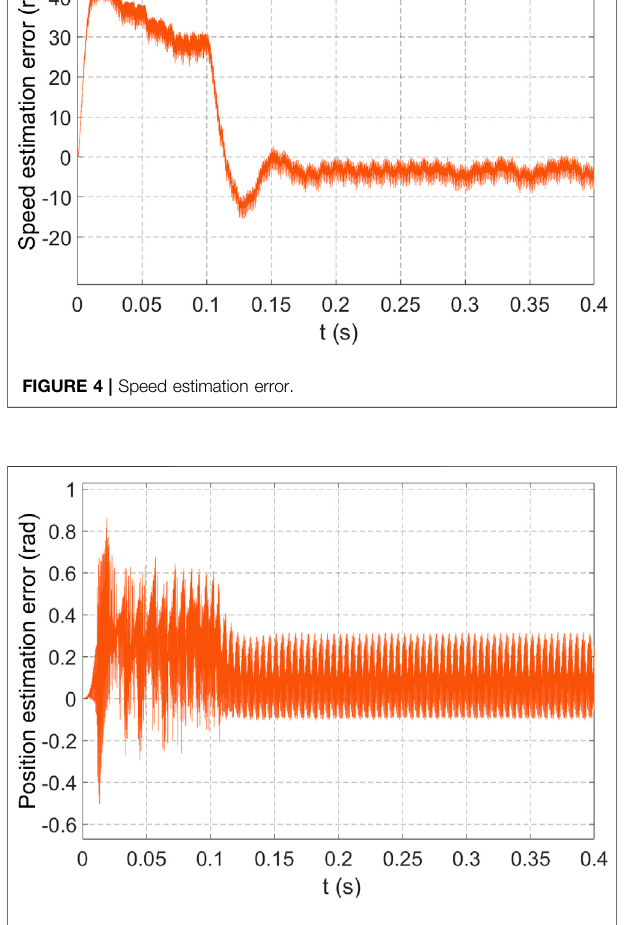
FIGURE 5 | Position estimation error.